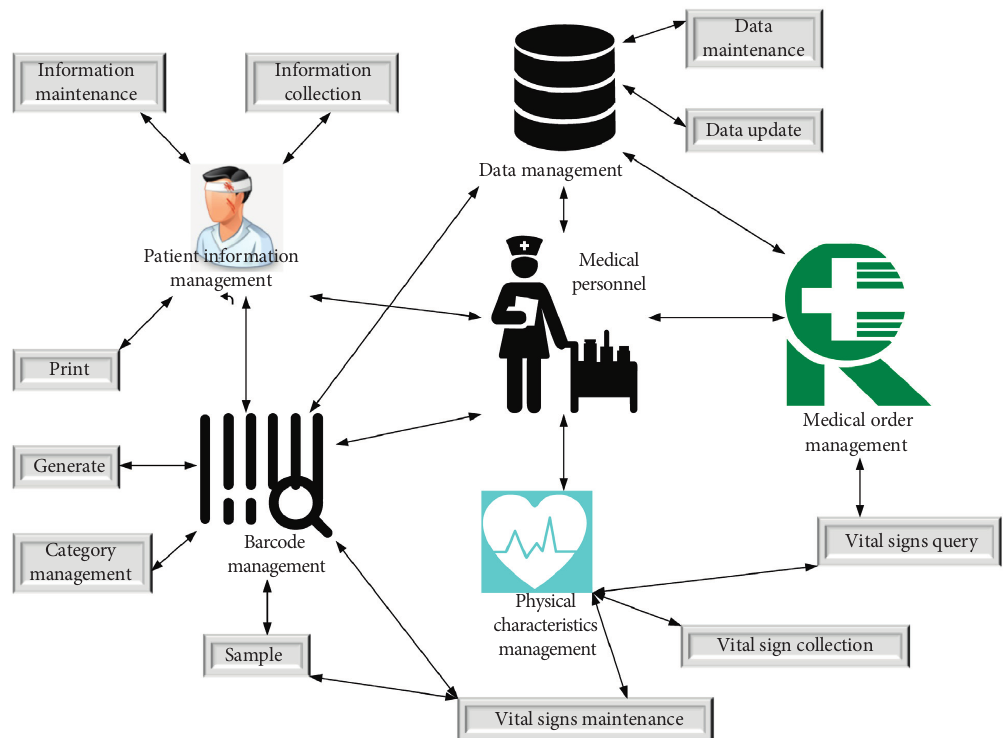
Figure 2: The E-R model of the data mining model constructed by this research.